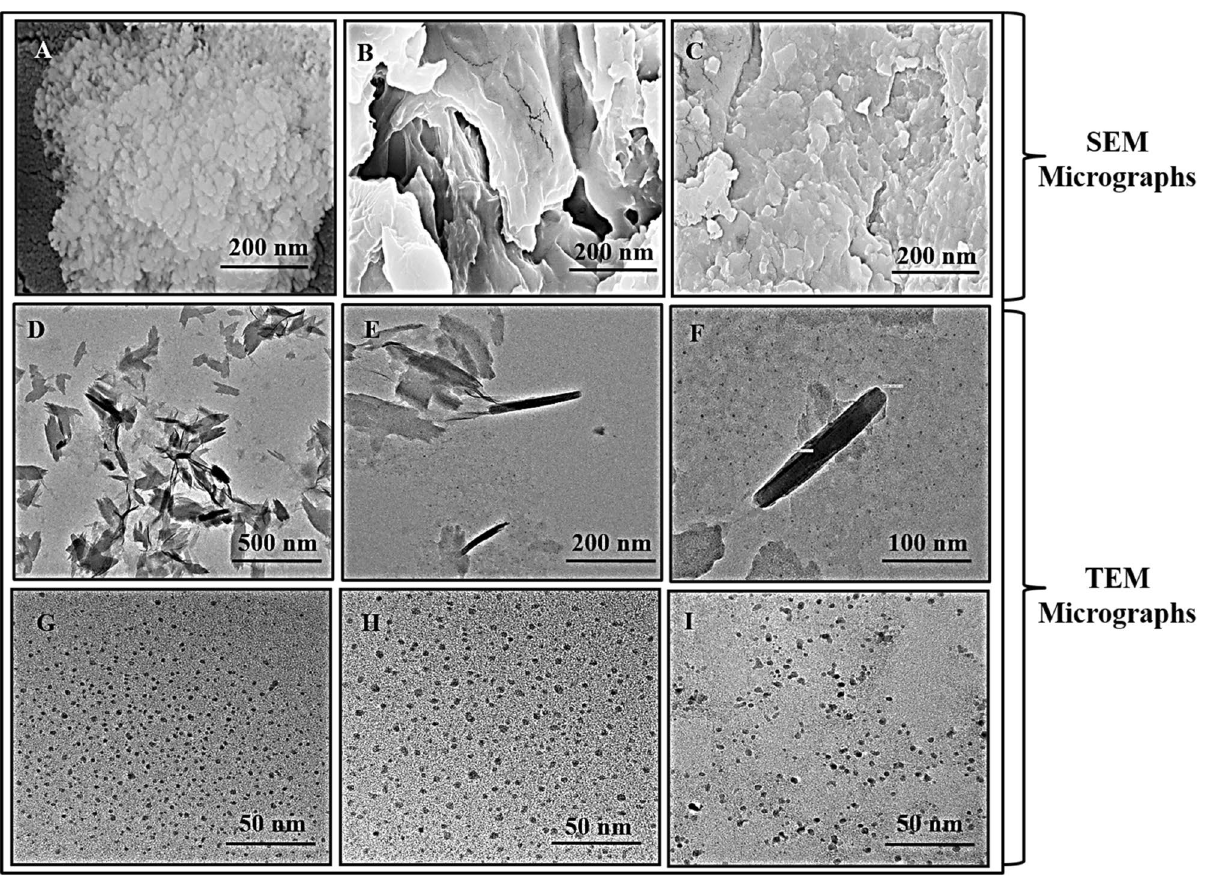
Figure 4. SEM micrographs showing surface morphology ( A ) Gliadin, HPW-42, ( B ) Secalin, MCTLG-5, ( C ) Hordein, BH-393. TEM micrographs showing ( D ) rod shaped HPW-42 Gliadin at 500 nm, ( E ) rod shaped HPW-42 Gliadin at 200 nm ( F ) rod shaped HPW-42Gliadin at 100 nm, ( G ) HPW-42 Gliadin at 50 nm, ( H ) MCTLG-5Secalin at 50 nm, and ( I ) BH-393Hordein at 50